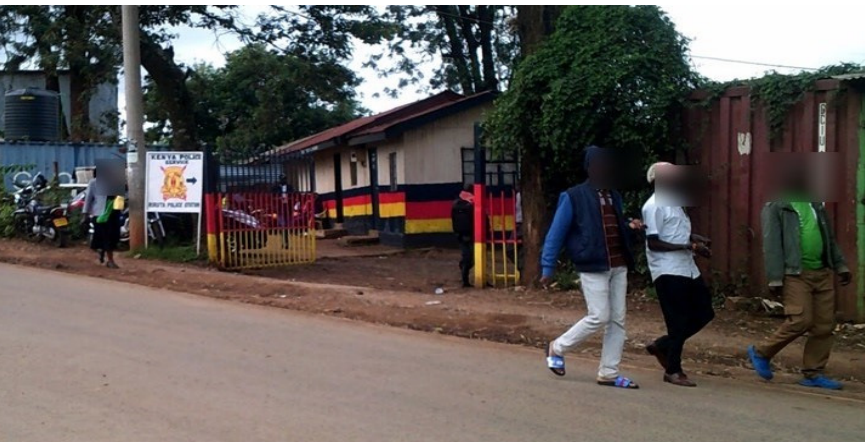
Figure 5. A police station where a participant expected to report and receive intervention for LGBTI- related crimes.